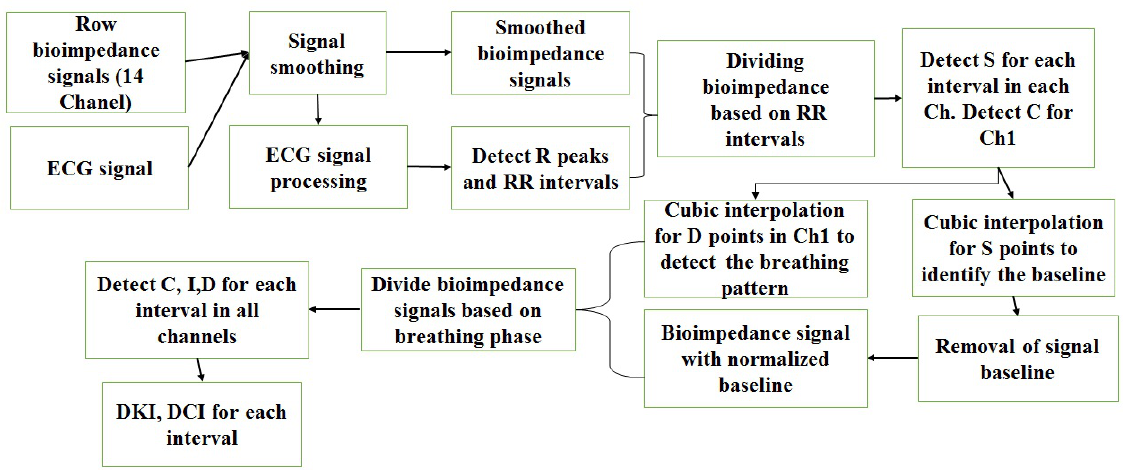
Figure 4. Basic signal processing